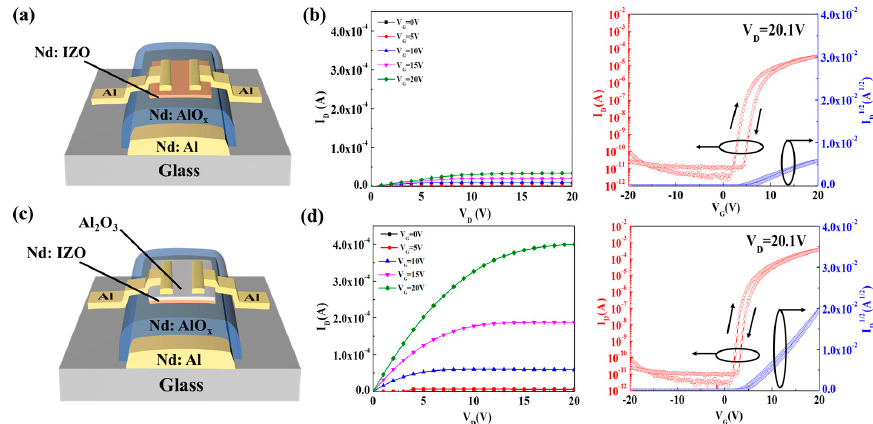
Figure 1. The schematic diagrams and output/transfer characteristics of ( a , b ) a single neodymium-doped indium zinc oxide (Nd:IZO) thin film transistor (TFT) and ( c , d ) an Nd:IZO/Al 2 O 3